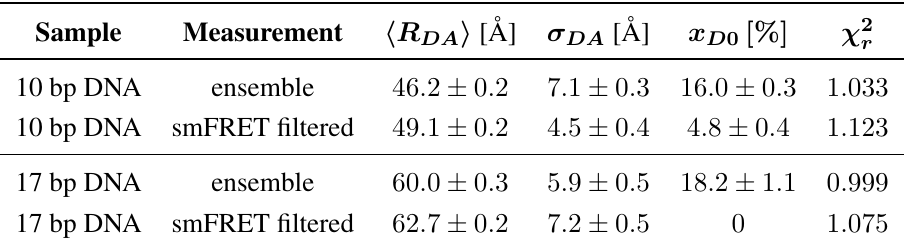
Table 1. Fitting results obtained from ensemble and smFRET-filtered lifetime measurements performed with 10-bp and 17-bp DNA